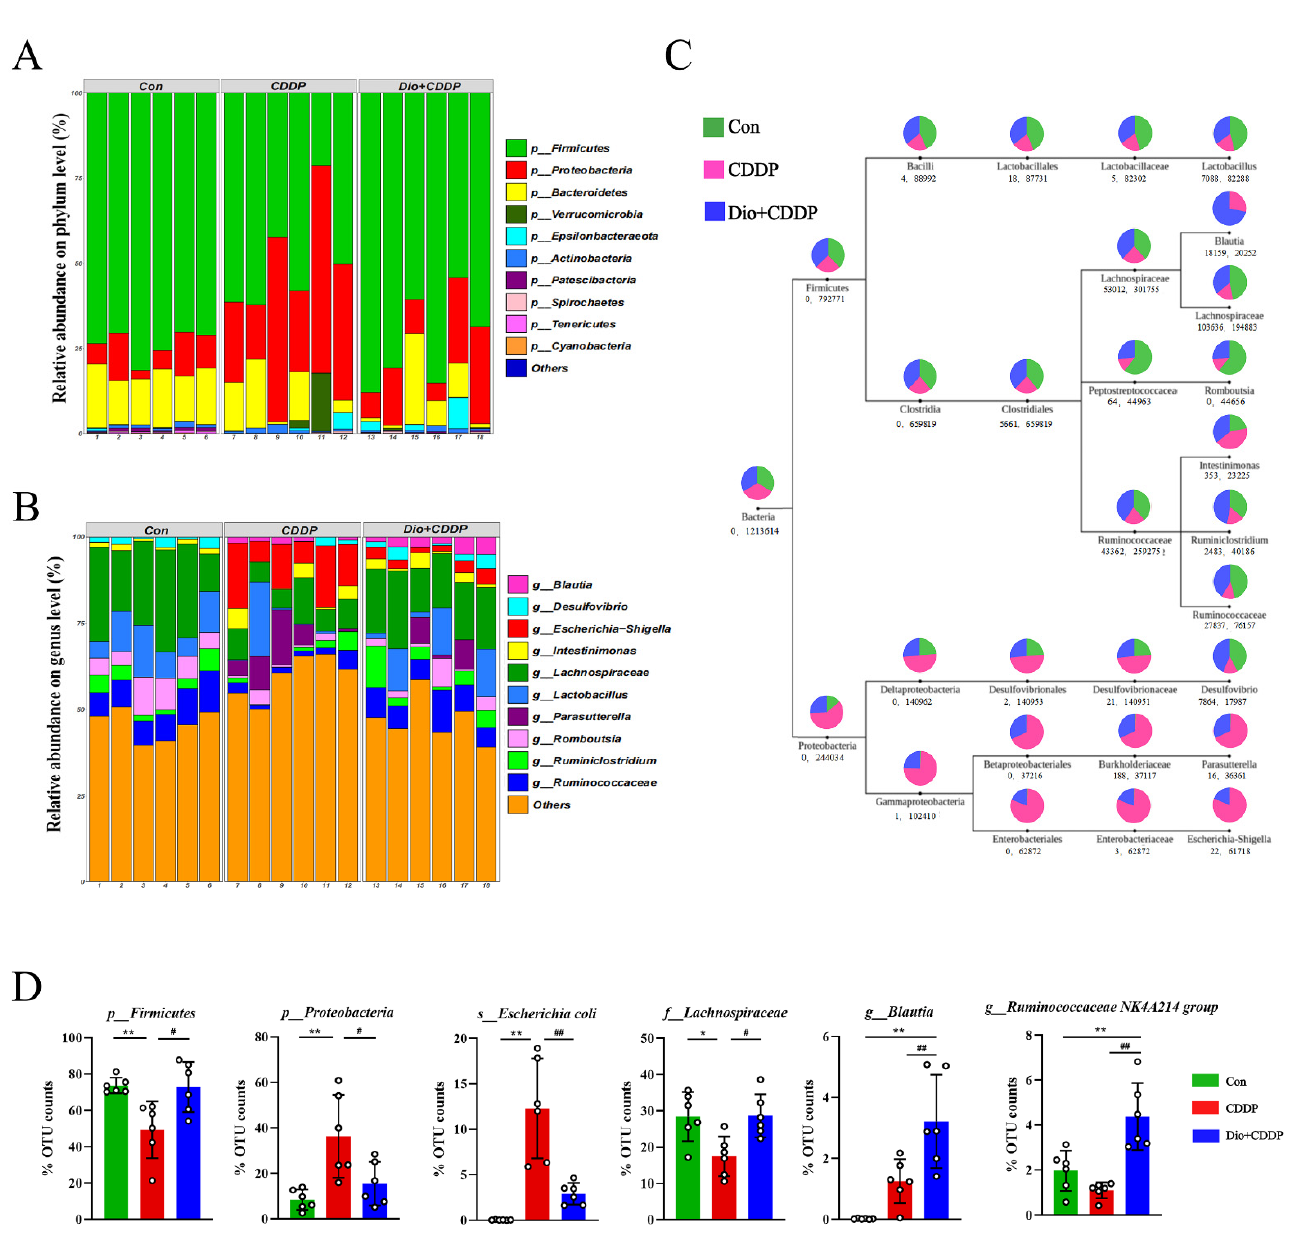
Figure 7. Taxonomic shifts in the microbes. ( A ) The proportion of dominant communities at the phylum level in each group of samples. ( B ) The proportion of dominant communities at the genus level in each group of samples. ( C ) Classification tree. The first circle represents the kingdom level (bacteria). The second circle (in same column) represents the phylum level. The subsequent order is class, order, family and genus. The number below the circle, the first indicates the number of sequences aligned to that classification only, and the second number indicates how many sequences are aligned to that classification in common. ( D ) Biomarkers are represented by the bar chart. The relative abundance with statistical differences biomarkers were compared among groups, including p-Firmicutes , p-Proteobacteria , s-Escherichia coli , f-Lachnospiraceae , g-Blautia , g-Ruminococcaceae NK4A214. * p < 0.05, ** p < 0.01 vs. control group, # p < 0.05, ## p < 0.01 vs. CDDP group.